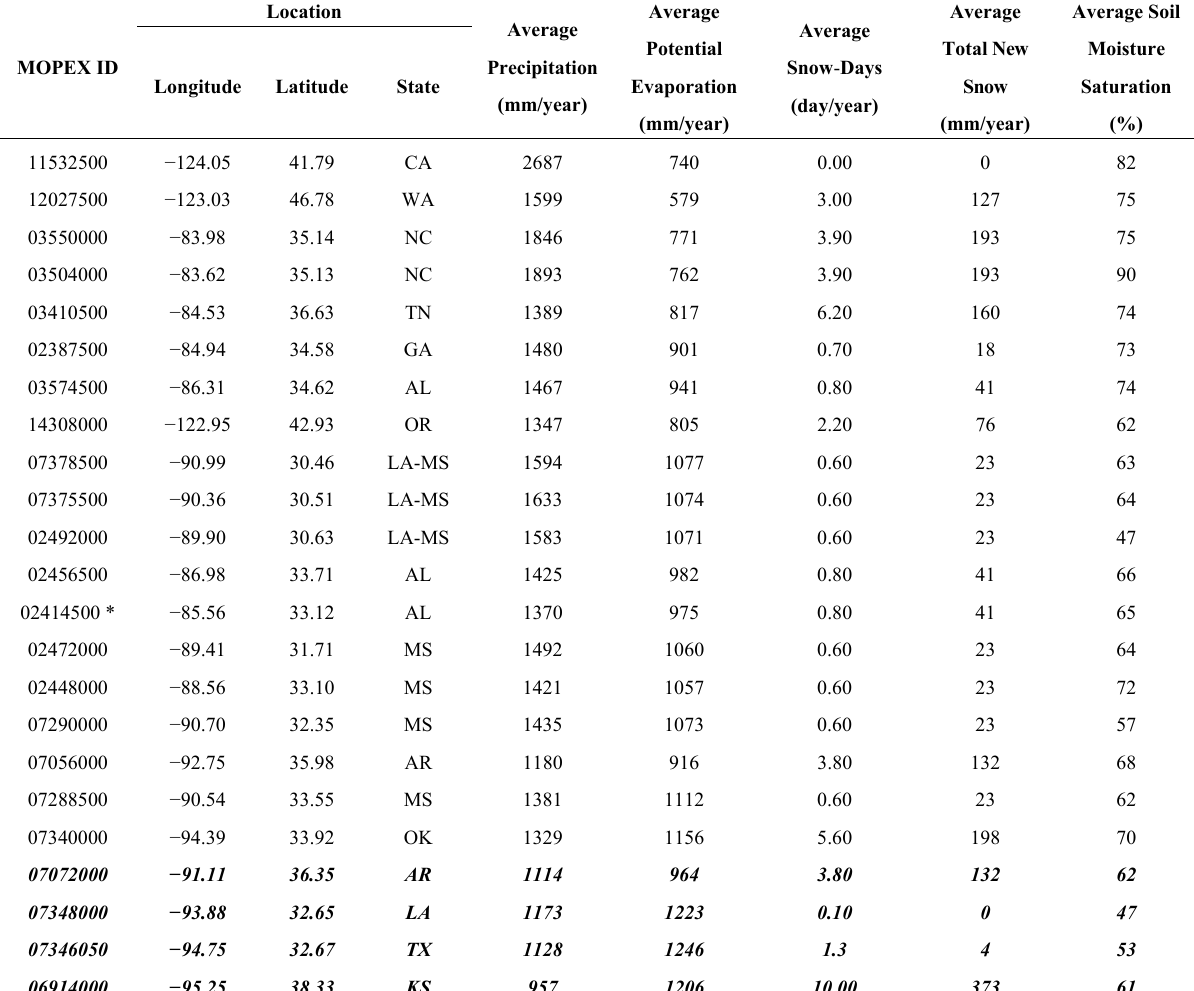
Table 1. Studied MOPEX basins, locations and basic